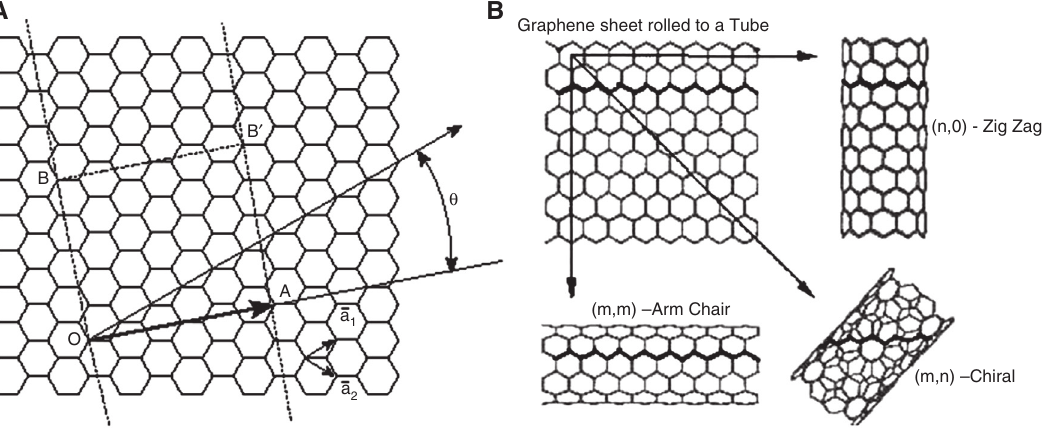
Here, represents the repulsive pair-wise potential, such as the core-core interactions, of the poten- tial function and represents the attractive part of the potential function that represents the bonding nanotube structure is given by the sum of valence bond energies and the non-bonding interactions